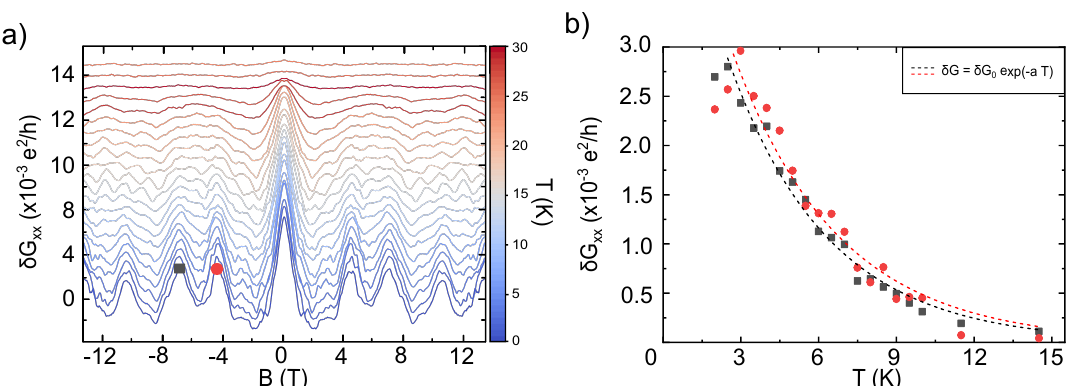
= − 12V. a) The back- Figure 4: Temperature dependency of AB-type oscillations at V g ground subtracted magnetoconductance data δ G of the narrow gated nanoribbon xx is shown at different temperatures. The temperature-dependent oscillation ampli- tude at B = ± 4.15T (black circles) and at B = ± 7.1T (red circles) is shown in b). An exponential fit has been performed to both datasets. An exponential fit as described in the main text is performed on both curves and the best fits are highlighted as a dashed black and dashed red line,